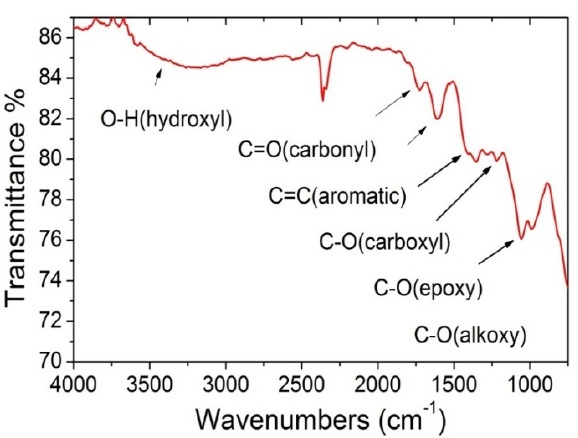
Figure A4. GO FTIR spectrum of GO sheets used in the preparation of alginate beads.